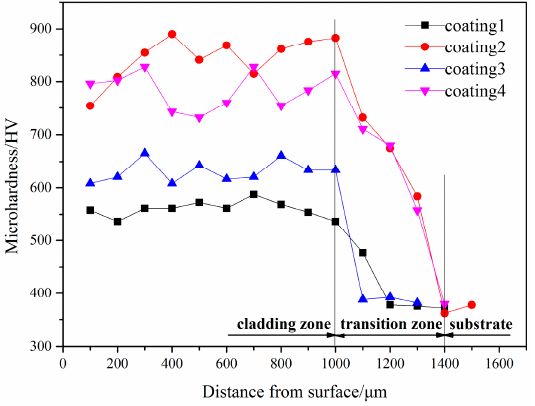
Figure 8. Microhardness of the laser cladding coatings along the depth.